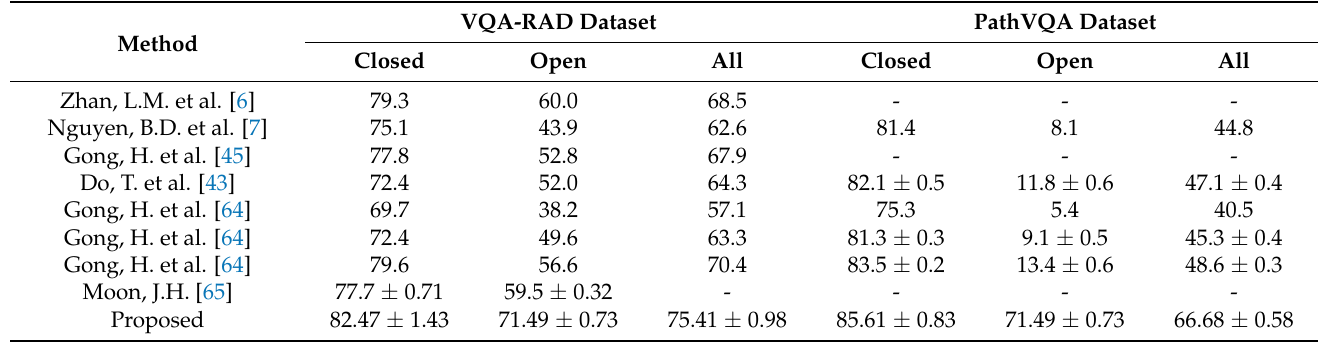
Table 5. Comparison with state-of-the-art